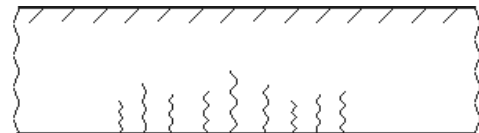
Fig 1. Initial stage of defect – micro crack propagation on all internal surfaces of object